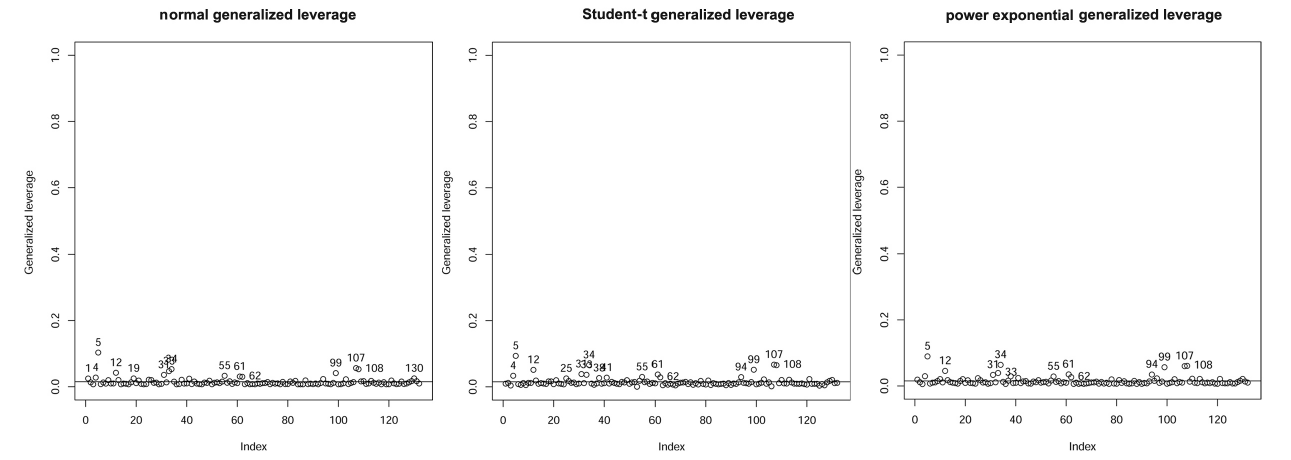
Figure 10. Plots of generalized leverage for the indicated models with data of monthly returns. Table 8. Generalized leverage influencing values in the indicated model with data of monthly returns. Month